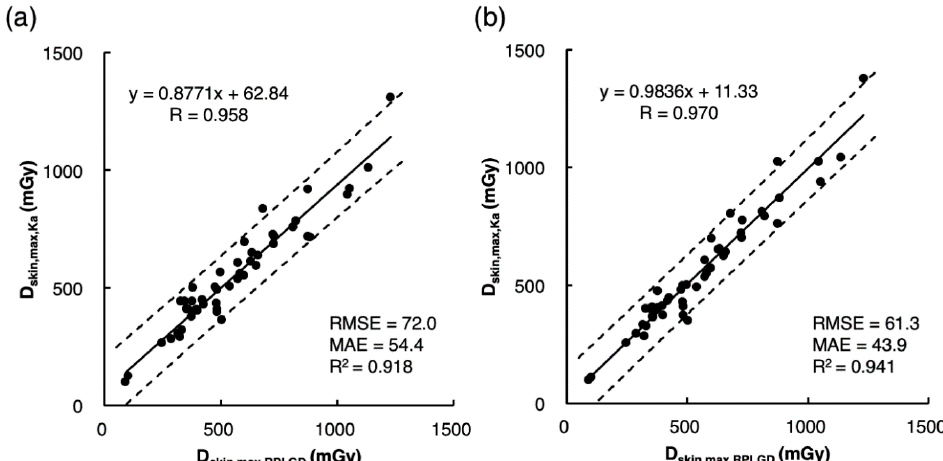
Figure 3. Investigation of the accuracy of the two indirect methods for estimating D skin,max,Ka using the test data set ( n = 50). ( a ) Correlation between the value of D skin,max,Ka indirectly estimated using an arbitrary constant CF Ka,constant (Estimation Model 1) and D skin,max,RPLGD directly estimated using radio-photoluminescence glass dosimeters (RPLGDs); ( b ) correlation between the value of D skin,max,Ka indirectly estimated using an arbitrary quadratic function CF Ka,function (Estimation Model 2) and D skin,max,RPLGD directly estimated using RPLGDs. The broken lines indicate 95% predictive intervals.